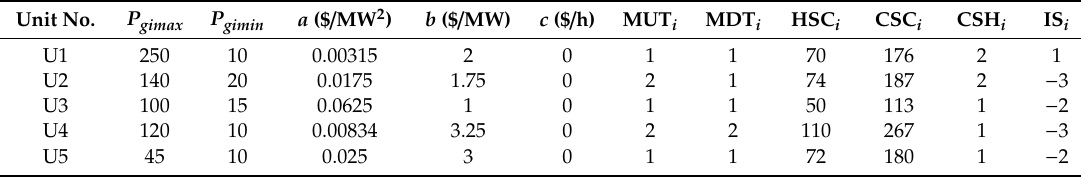
Table 1. System data for 5-unit system.